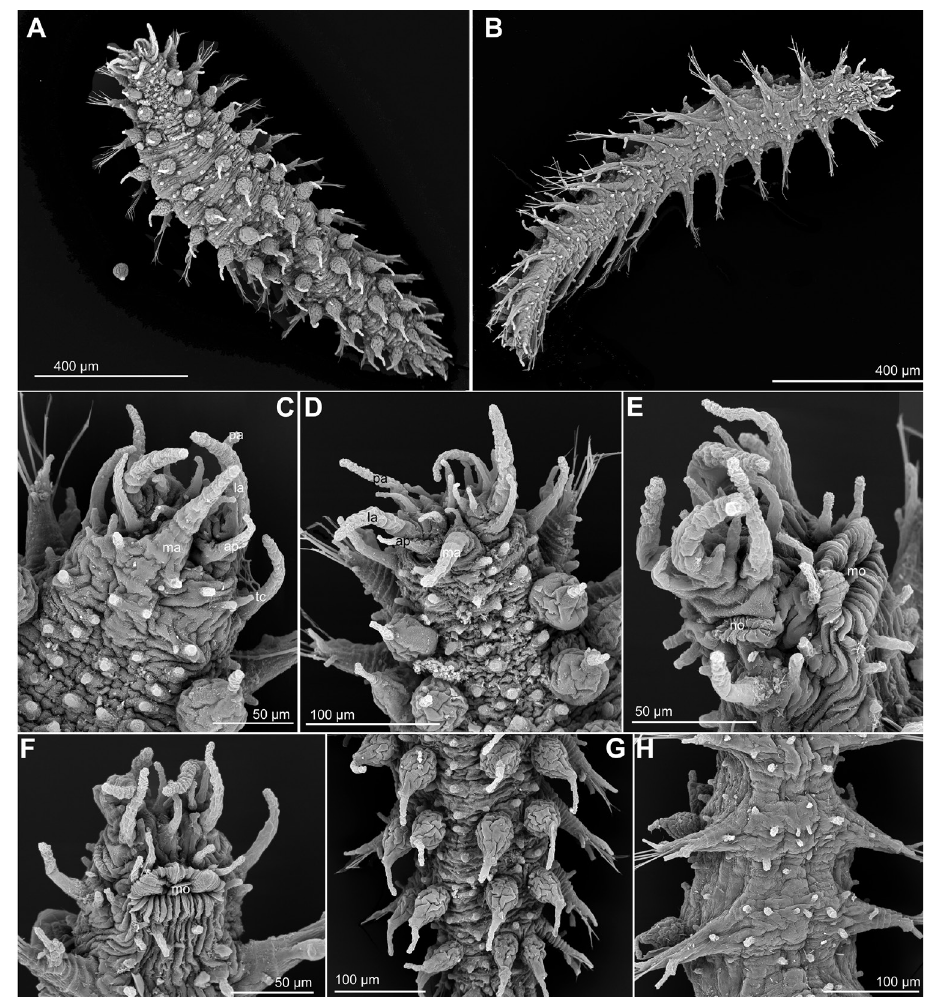
Figure 5. Sphaerephesia amphorata sp. n., paratypes, USNM 1002041, SEM. A Whole specimen, dorsal view B Same, ventral view C Anterior end, showing head appendages, dorsal view D Same, with head papillae visible E Same, lateroventral view; mouth and nuchal organ pits, visible F Anterior end, ventral view G Posterior chaetigers, dorsal view, showing the characteristic dorsal macrotubercles with long ter- minal papillae H Mid-body chaetigers, ventral view. Abbreviations: lateral antenna; ma, median antenna; mo, mouth; no, nuchal organ; pa, palp; tc, tentacular cirrus.